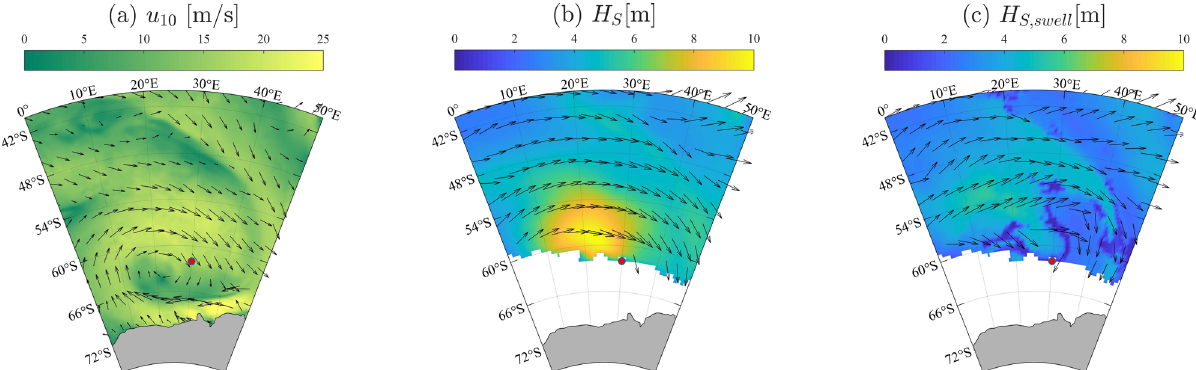
Fig. 1 | Daily averaged environmental conditions on the 4th July 2017 from ERA5.a Windspeed; b totalwaveheightand c swellwaveheight.Vectorsshowthe direction, where in b , c the length is proportional to the wave period. The hor- izontal and vertical axis denotes Easting (longitude) and Northing (latitude) in